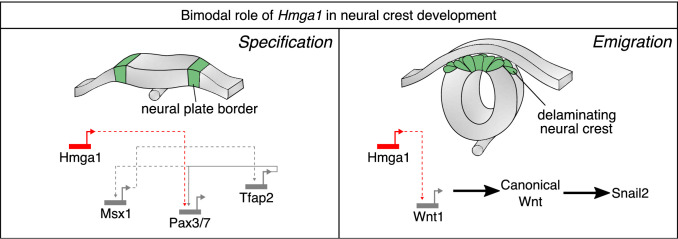
Current model for Hmga1 function in chick neural crest development.Our data suggest that Hmga1 plays temporally distinct roles in the neural plate border and dorsal neural tube. At the neural plate border, Hmga1 acts upstream of Pax7 and is required for proper neural crest specification. Later, in the dorsal neural tube, Hmga1 regulates the levels of Wnt1, thereby modulating the levels of canonical Wnt signaling to control neural crest delamination and subsequent migration.